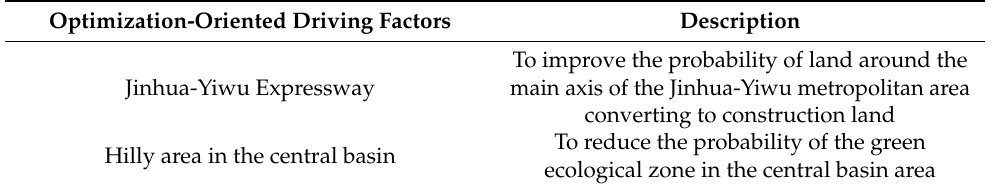
Table 2. Optimization-oriented driving